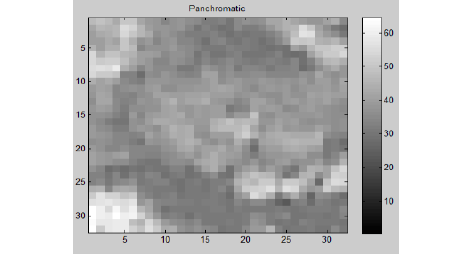
Figure 9c. Projected 32 × 32 pixels for blue channel Downsampling of projected 32 × 32 pixels high resolution multispectral gives 8× 8 pixels dataset as shown in figure 10. Red Green Blue